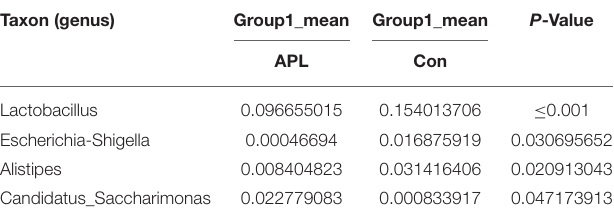
TABLE 3 | Based on Metastats analysis for flora differences between APL and Con groups under the genus.